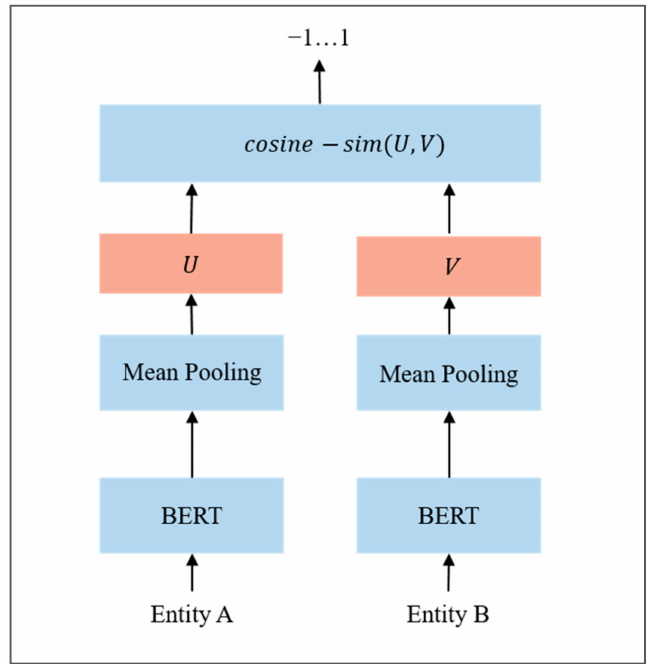
Figure 11. SBERT model